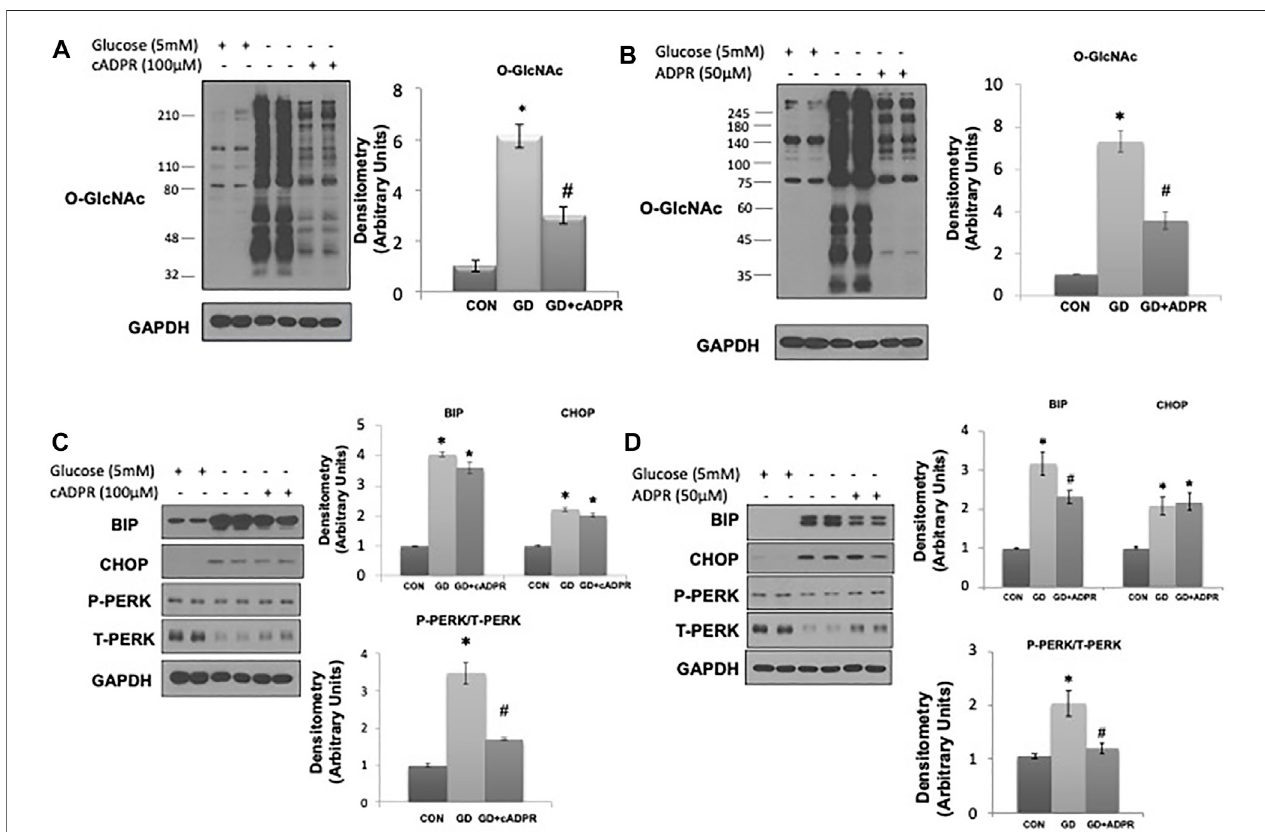
FIGURE 2 | The effects of cADPR and ADPR on the glucose deprivation induced increase in O-GlcNAc and ER Stress in AC16 cells. (A) Left panel: O-GlcNAc immunoblotswithand withoutglucose inthepresenceor absenceofcADPR(100 µM). RightpanelQuanti fi cationofimmunoblotsnormalizedtoGAPDH. (B) Leftpanel: O-GlcNAc immunoblots with and without glucose in the presence or absence of ADPR (50 µM). Right panel: Quanti fi cation of immunoblots normalized to GAPDH. (C) Left panel: BiP, CHOP, phospho- (P) and total (T) PERK immunoblots, with and without glucose in the presence or absence of cADPR (100 µM). Right panel: Quanti fi cationofimmunoblotsnormalizedtoGAPDH. (D) Leftpanel:BiP,CHOP,phospho-(P)andtotal(T)PERKimmunoblots,withandwithoutglucoseinthepresence orabsenceofADPR(50 µM).Rightpanel:Quanti fi cationofimmunoblotsnormalizedtoGAPDH.* p < 0.05vs.Control(Con)group;# p < 0.05vs.glucosedeprivation(GD) group. All data are expressed as mean ± S.E.M. of 3 – 6 independent